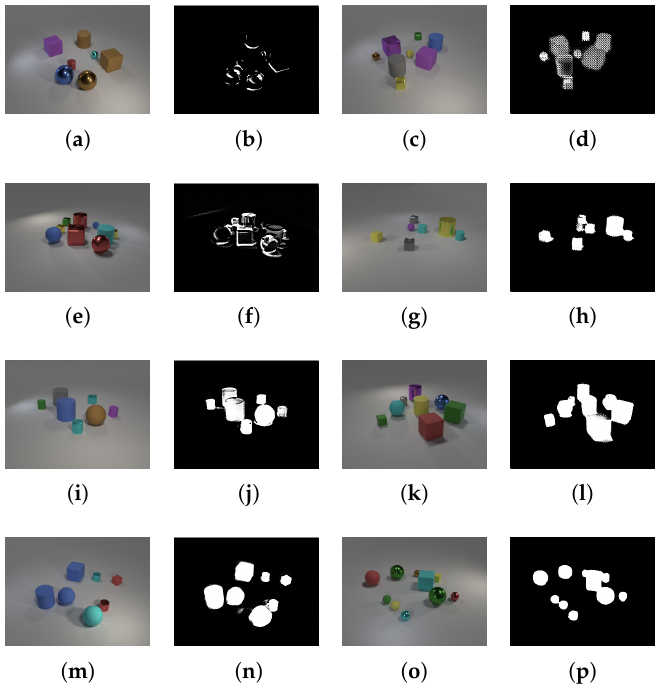
Figure 7. Example images at different iterations from the CLEVR dataset; ( a ) input; ( b ) seg. 200; ( c ) input; ( d ) seg. 200; ( e ) input; ( f ) seg. 400; ( g ) input; ( h ) seg. 400; ( i ) input; ( j ) seg. 600; ( k ) input; ( l ) seg. 600; ( m ) input; ( n ) seg. 1000; ( o ) input; ( p ) seg.